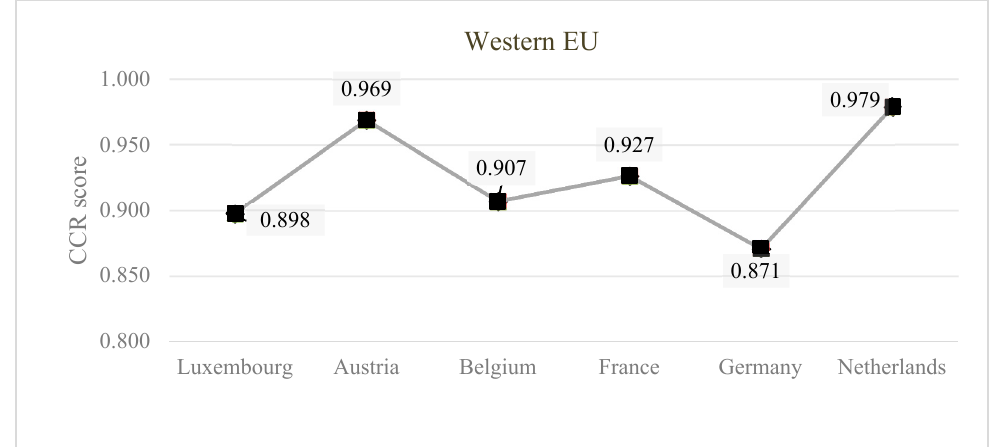
Figure 5. Results of the CCR model in the Western EU. Source: own processing.